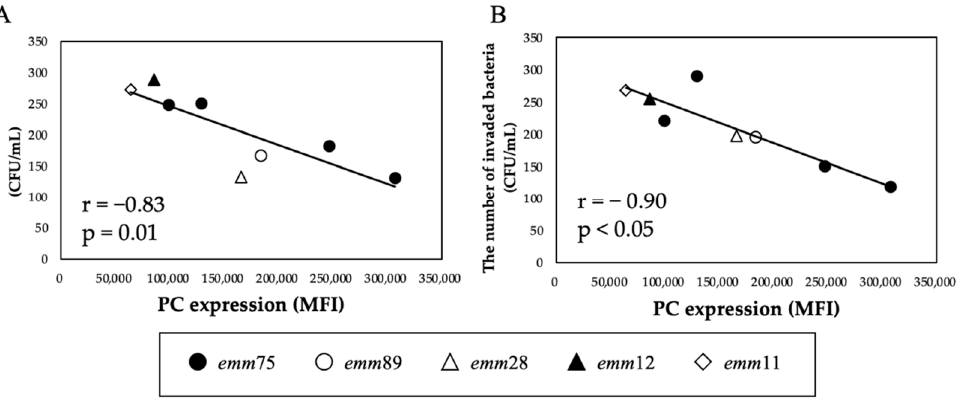
Figure 5. Inhibitory effects of TEPC-15 and ABT-491 on cell invasion of Streptococcus pyogenes. Inhibition of invasion by pretreatment with TEPC-15 ( n = 5, r = − 0.83, p = 0.01) ( A ) and ABT-491 ( n = 5, r = − 0.90, p < 0.05) ( B ) showed a negative correlation with phosphorylcholine expression in Streptococcus pyogenes . MFI, mean fluorescence intensity.